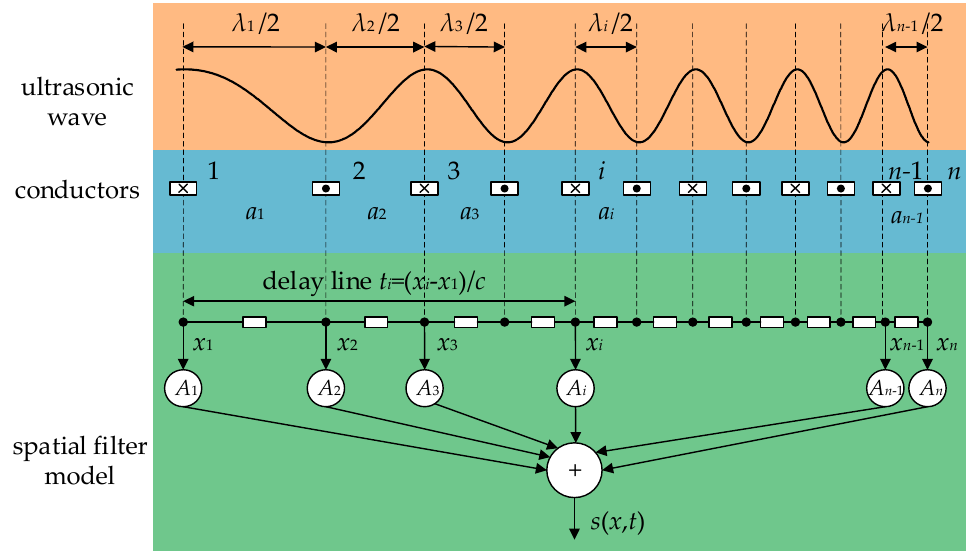
Figure 3. Spatial filter model for RW-EMAT with UES.